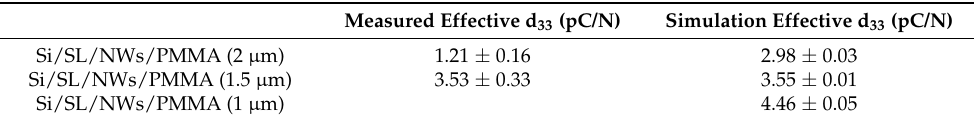
Table 2. Piezoelectric coefficient d 33 from experimental and COMSOL simulation.